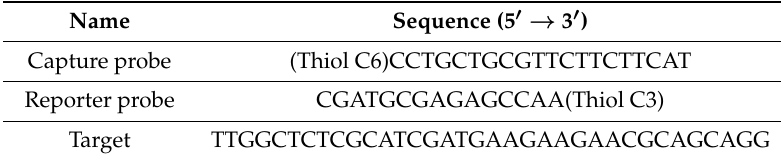
Table 1. List of ssDNA sequences used in these experiments.